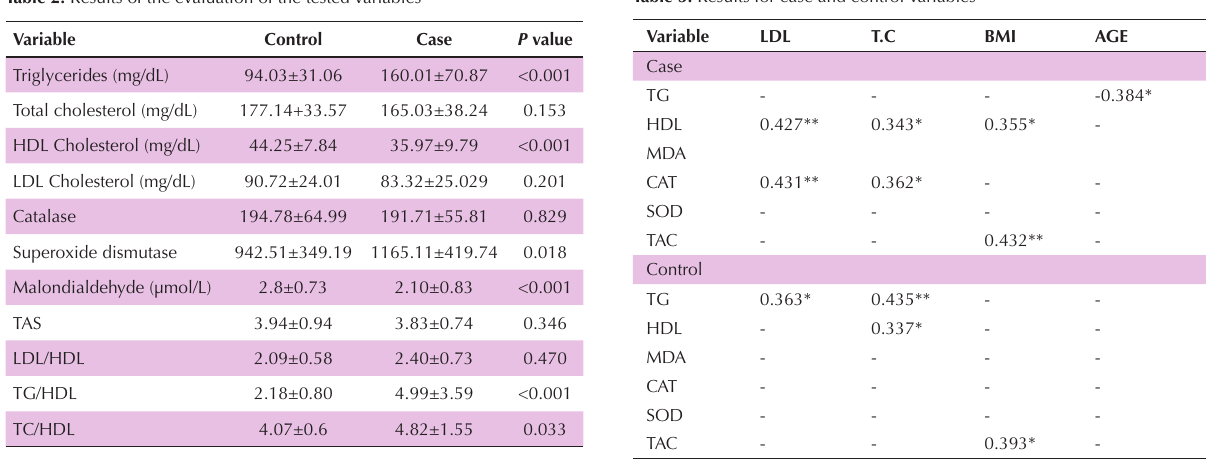
Table 2. Results of the evaluation of the tested variables Table 3. Results for case and control